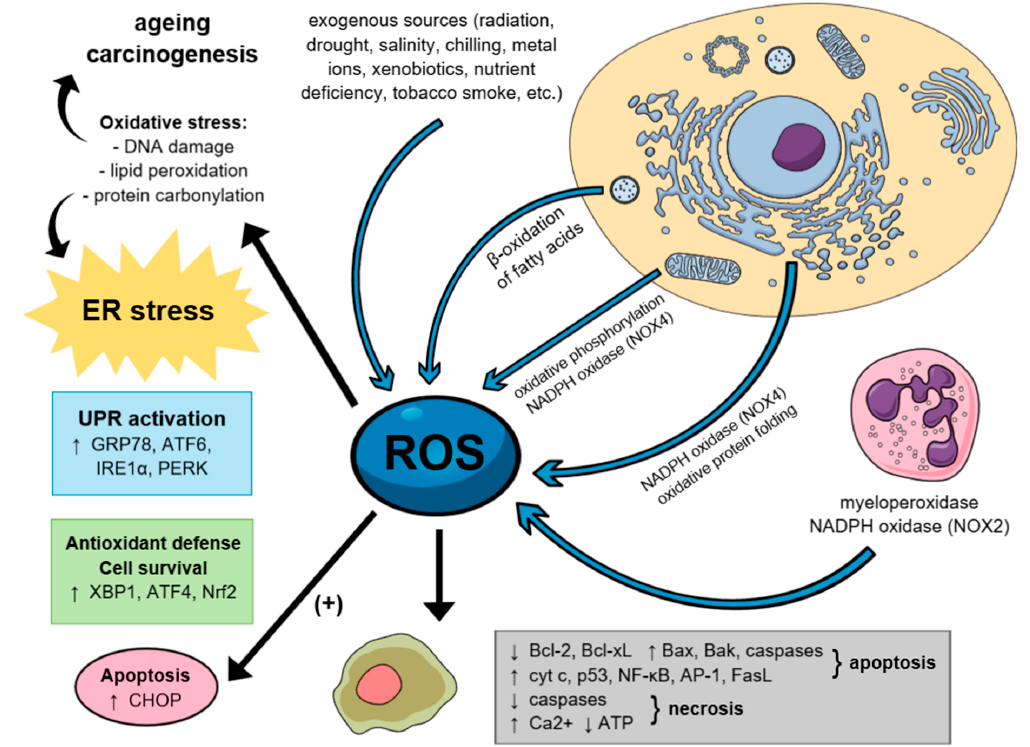
ff ect on cell viability. Reactive Oxygen